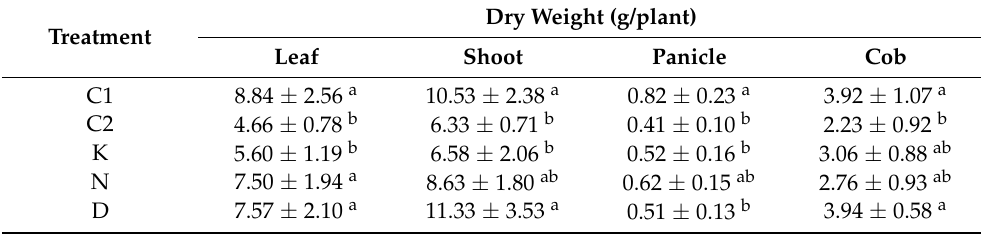
Table 4. Effects of phytostimulator treatments on dry weight of parts of maize plants. In each column, values followed by different letters indicate statistically significant ( p ≤ 0.05) differences, control treatment under normal growth conditions without cold stress (C1), second control treatment under stress growth conditions with cold (C2), Kelpak ® (K), Nano Active ® (N), Dynamic Cresco ® (D). Dry Weight (g/plant) Treatment